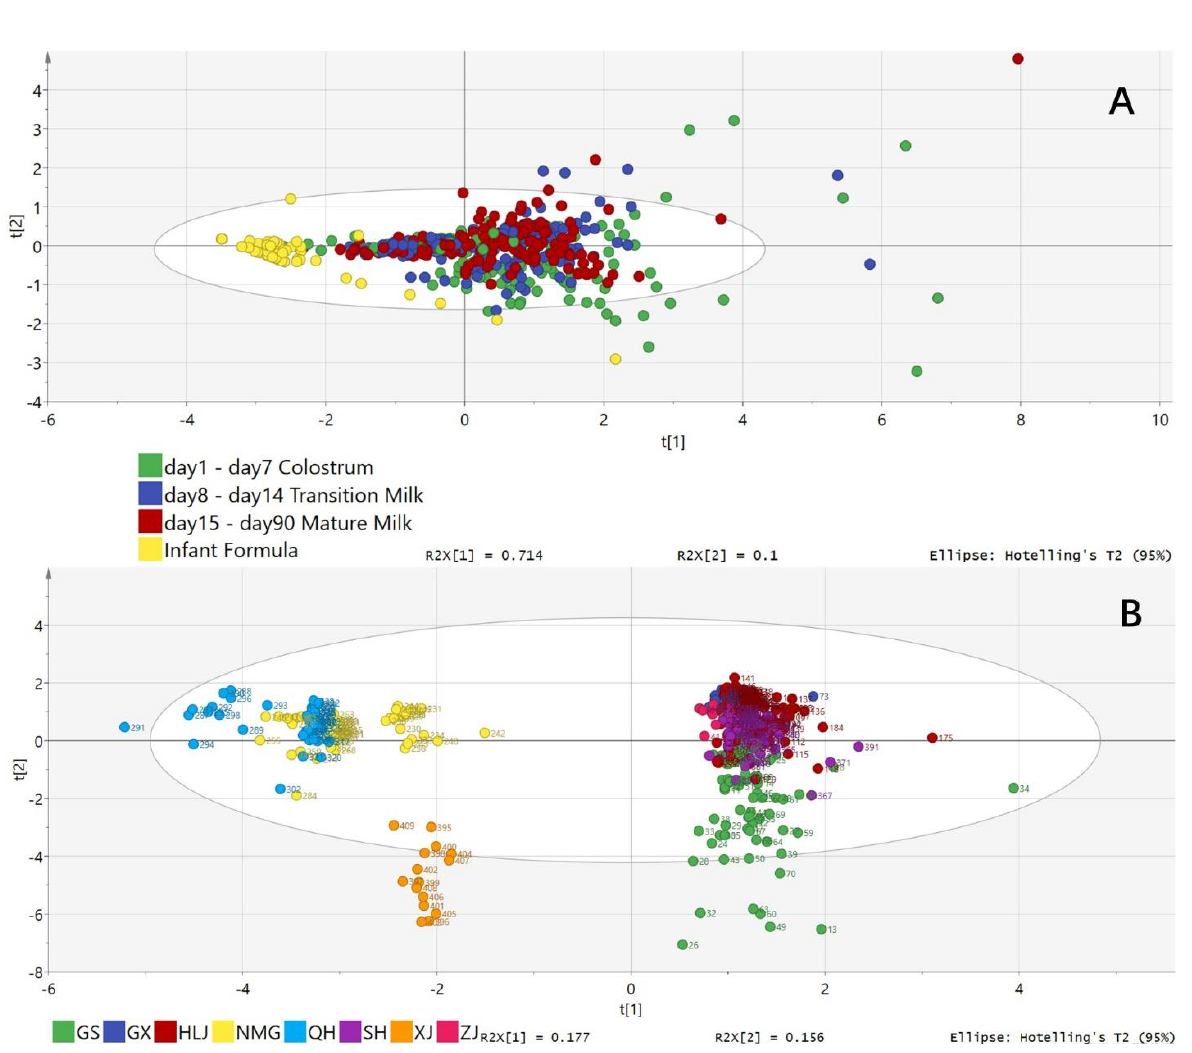
Figure 6. PDS-LA analysis of A : the difference between infant formulas and different human milks (Green: Colostrum, Blue: Transition milk, Red: Mature milk, Yellow: infant formula) and B : PDS-LA analysis of the difference of OCFA contents between human milks from different locations. GS = Gansu; GX = Guangxi; HLG = Heilongjiang; NMG = Neimenggu; QH = Qinghai; SH = Shanghai; XJ = Xinjiang; ZJ = Zhejiang.